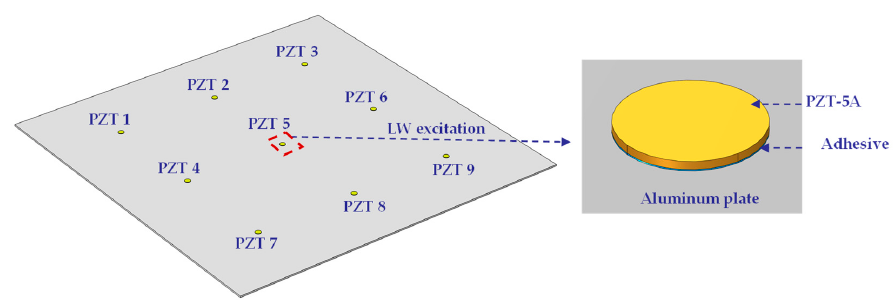
Figure 3. Architecture of multiphysics simulation method of LW under temperature effect.